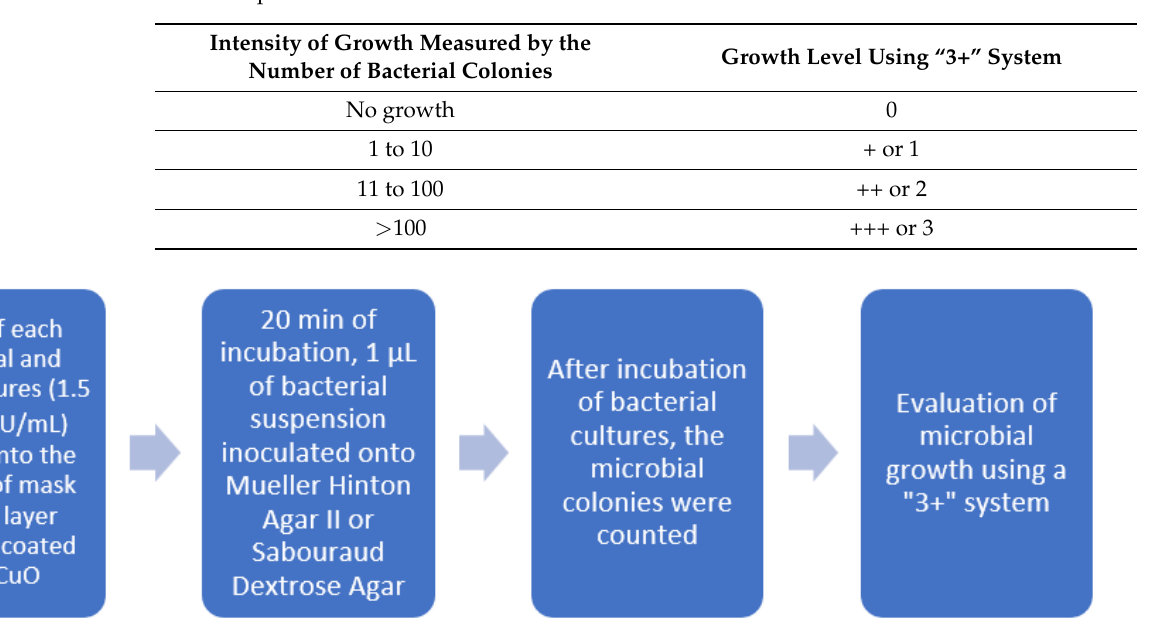
Table 1. Evaluation of microbial growth based on their ability to form colonies after exposure to CuO nanoparticles.